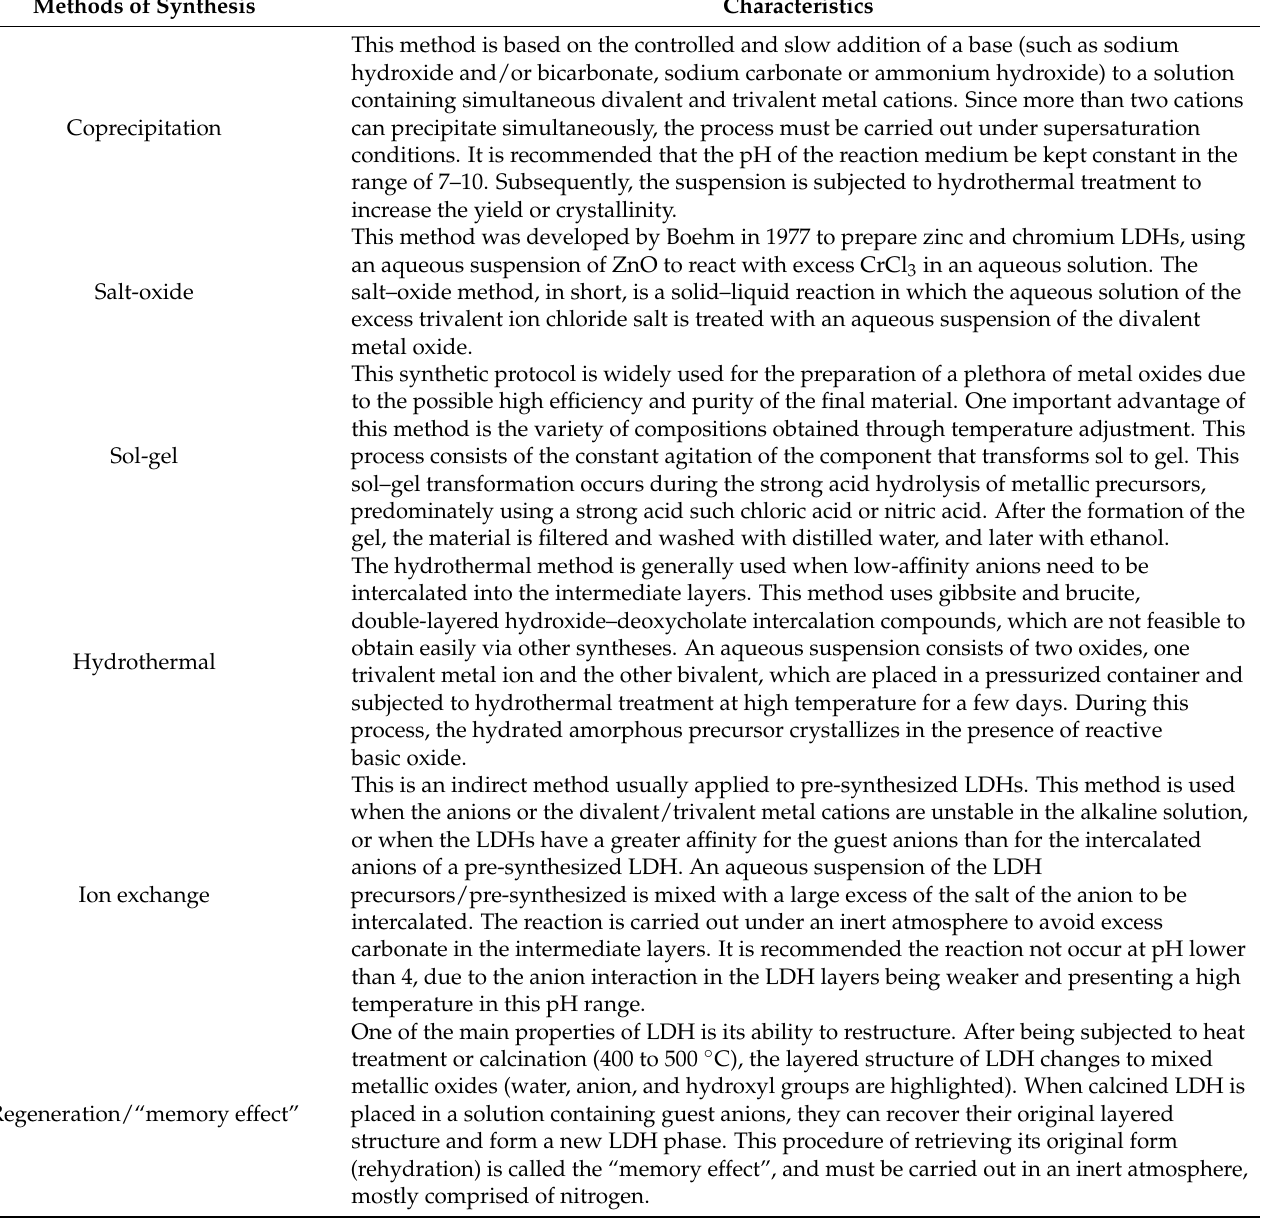
Table 2, we collected characteristics of methods of synthesis which can be followed for the preparation of pure LDHs, as well as their composites and hybrids [18,25,41,42]. Table 2. Provides details of some of the methods used for the synthesis of